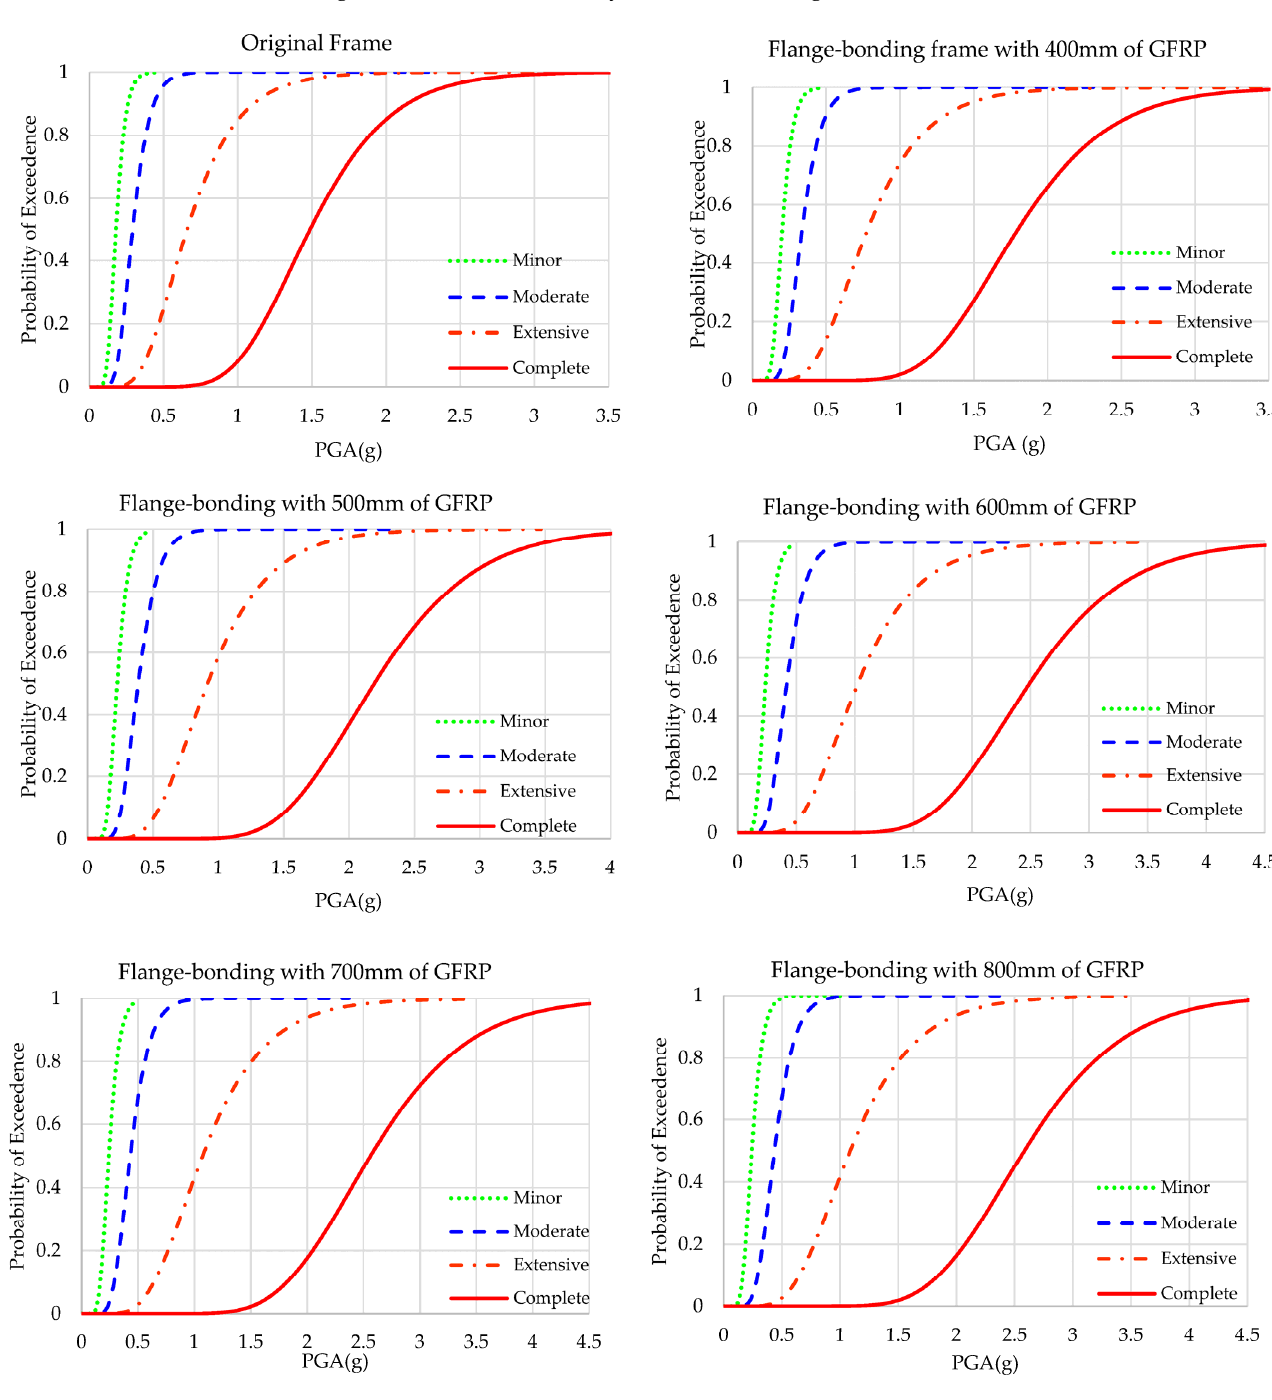
Figure 11. Fragility curves of the original and GFRP flange ‐ bonding frames.